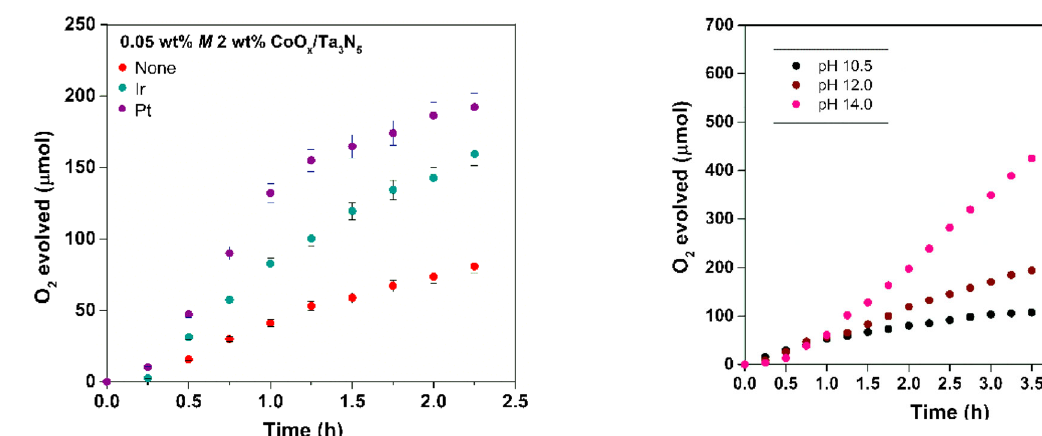
Fig. 9 Time course of photocatalytic OER on CoO x /Ta 3 N 5 (0.1 M Na 2 S 2 O 8 , pH 10.5 adjusted with NaOH under visible light irradiation (420 \ k \ 800 nm))